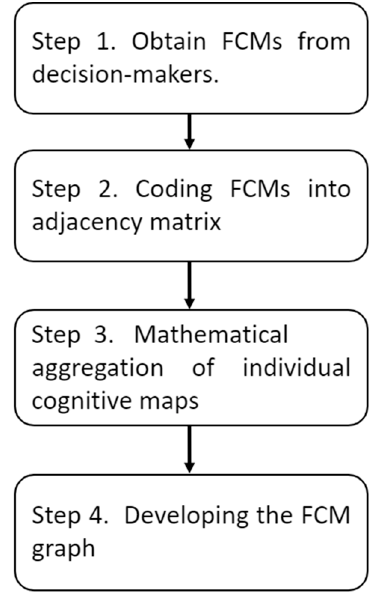
Figure 1. Fuzzy cognitive maps algorithm.